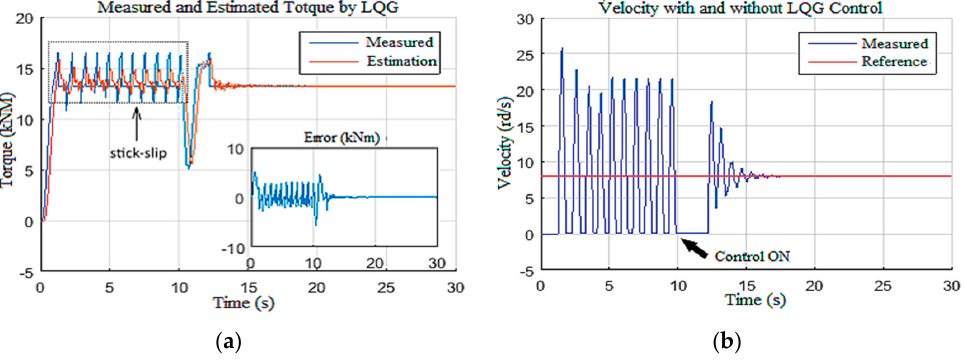
Figure 23. Output response for stick-slip suppression: ( a ) Tob; ( b ) bit velocity.